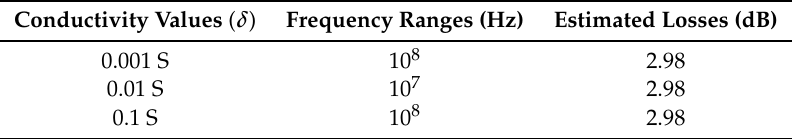
Figure 10. Absorption loss for MHz frequency (radios) at different conductivities of water. Table 5. Absorption Losses for MHz Radios at Different Conductivities of